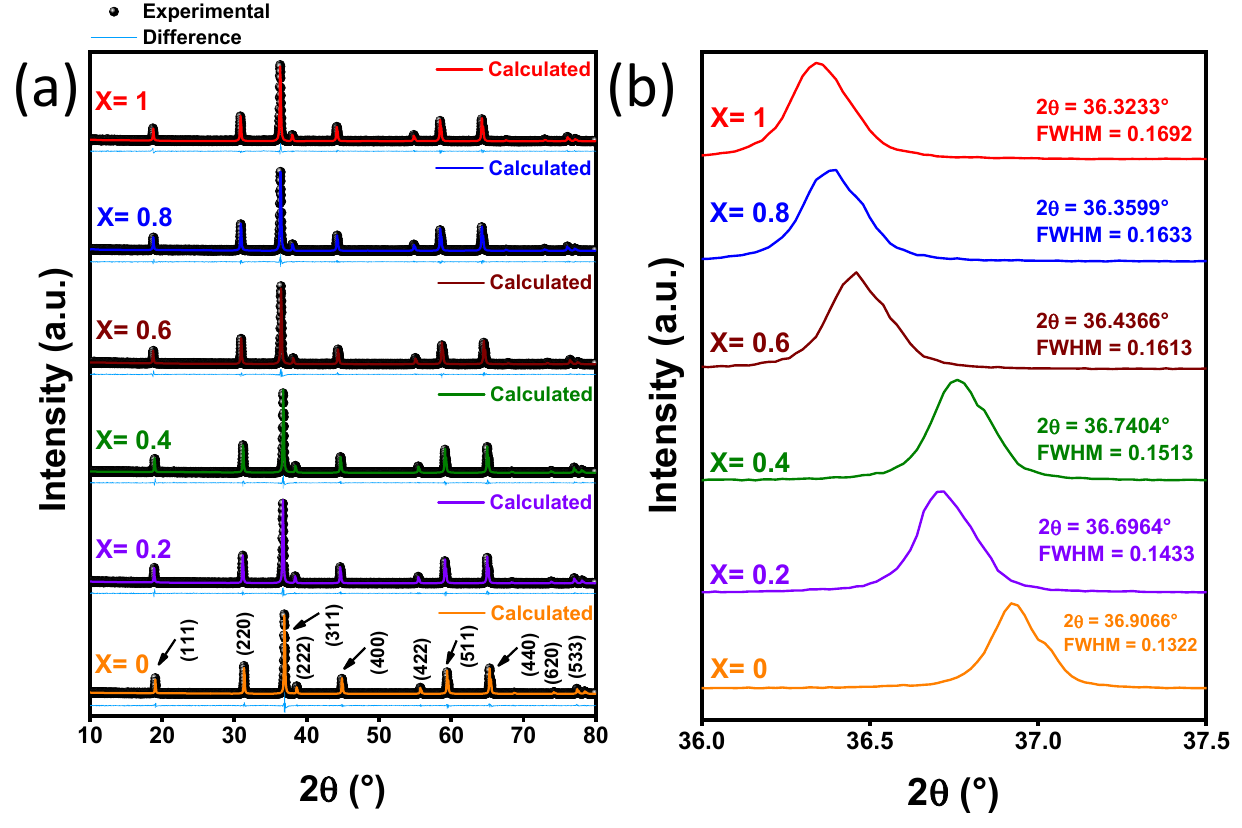
Figure 3. ( a ) XRD patterns of Mn X Co 3-X O 4 (0 ≤ X ≤ 1) samples ( b ) Peaks (311) for each sample and their positions and FWHM. Blue lines below the diffractograms are the difference between the calculated and experimental data. Table 1. Crystallographic parameters, including crystallite size, lattice parameter, and